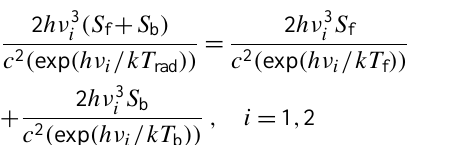
Figure 1. Comparison of predictions of the formula ( 10 ) with the observed H (panel a) and control (panel b) subsets. Parameter values ( 13 ). Unit=[m]